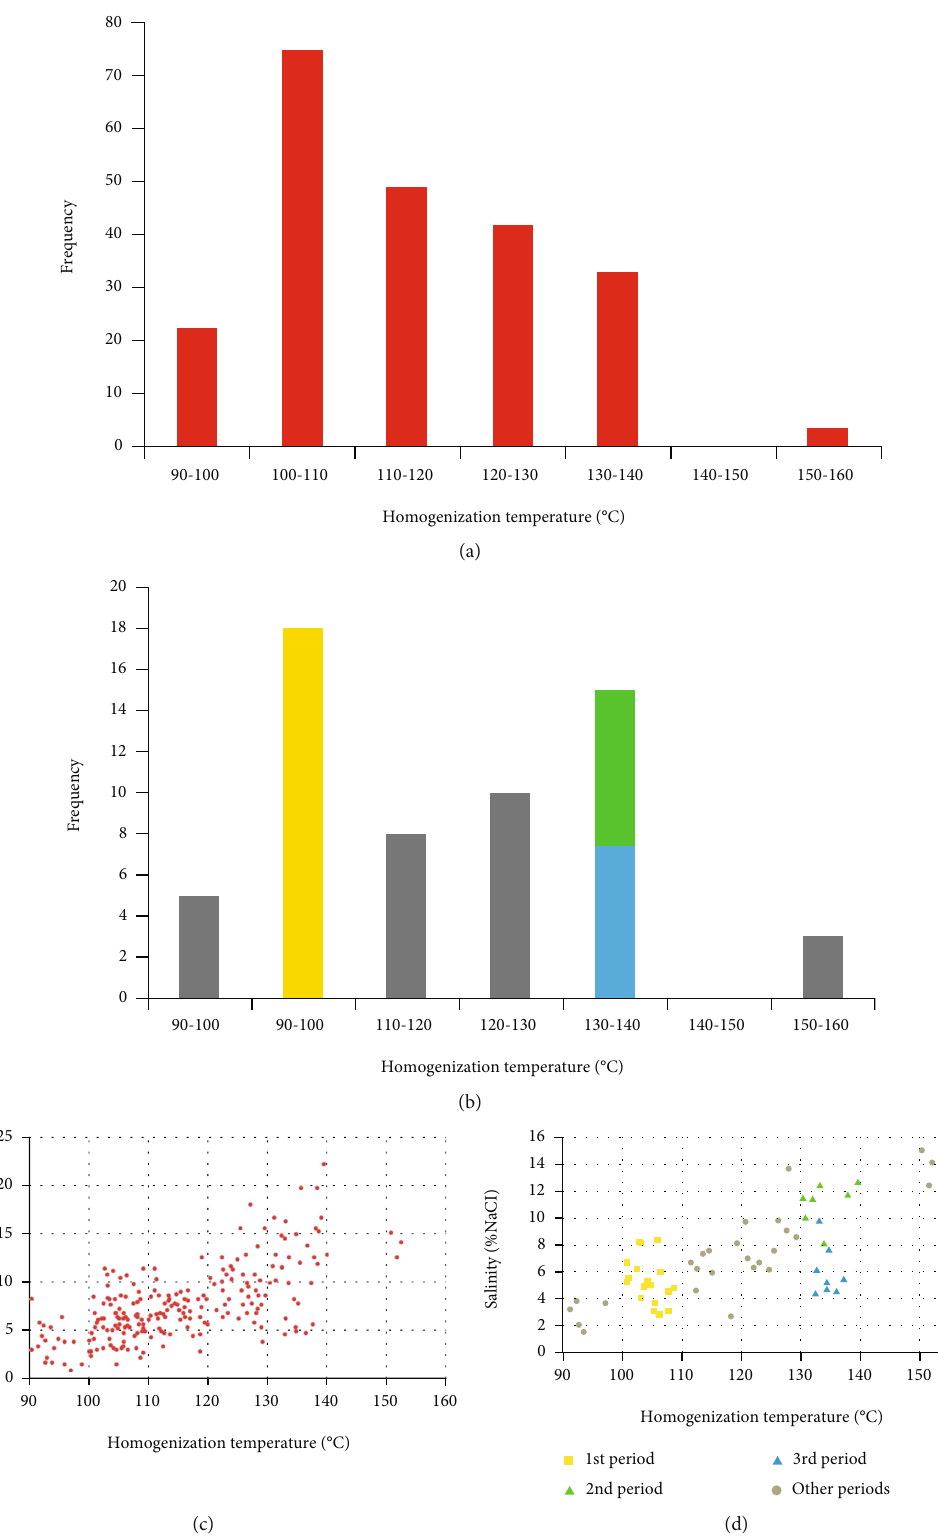
Figure 6: Microthermometry diagram of fl uid inclusions in the J inclusions in this study; (b) T h histograms of aqueous fl uid inclusions in AMO-2; (c) T h -salinity plot of all aqueous fl uid inclusions; (d) fl uid inclusions in T h -salinity plot of aqueous